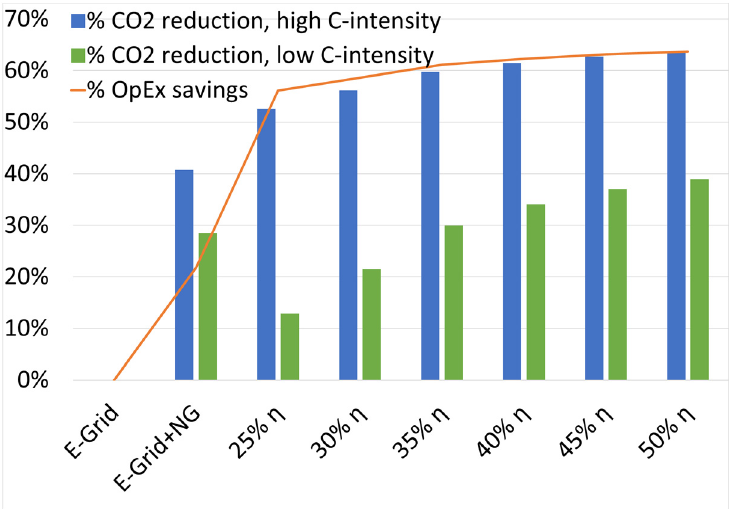
Figure 7. Environmental and economic analysis of cogeneration system-based configurations with different electrical efficiencies. Combined load of 28 kWh/day, 0.5 kW PV, 0.4 kW PM, and 2 kWh electrical storage capacitance.